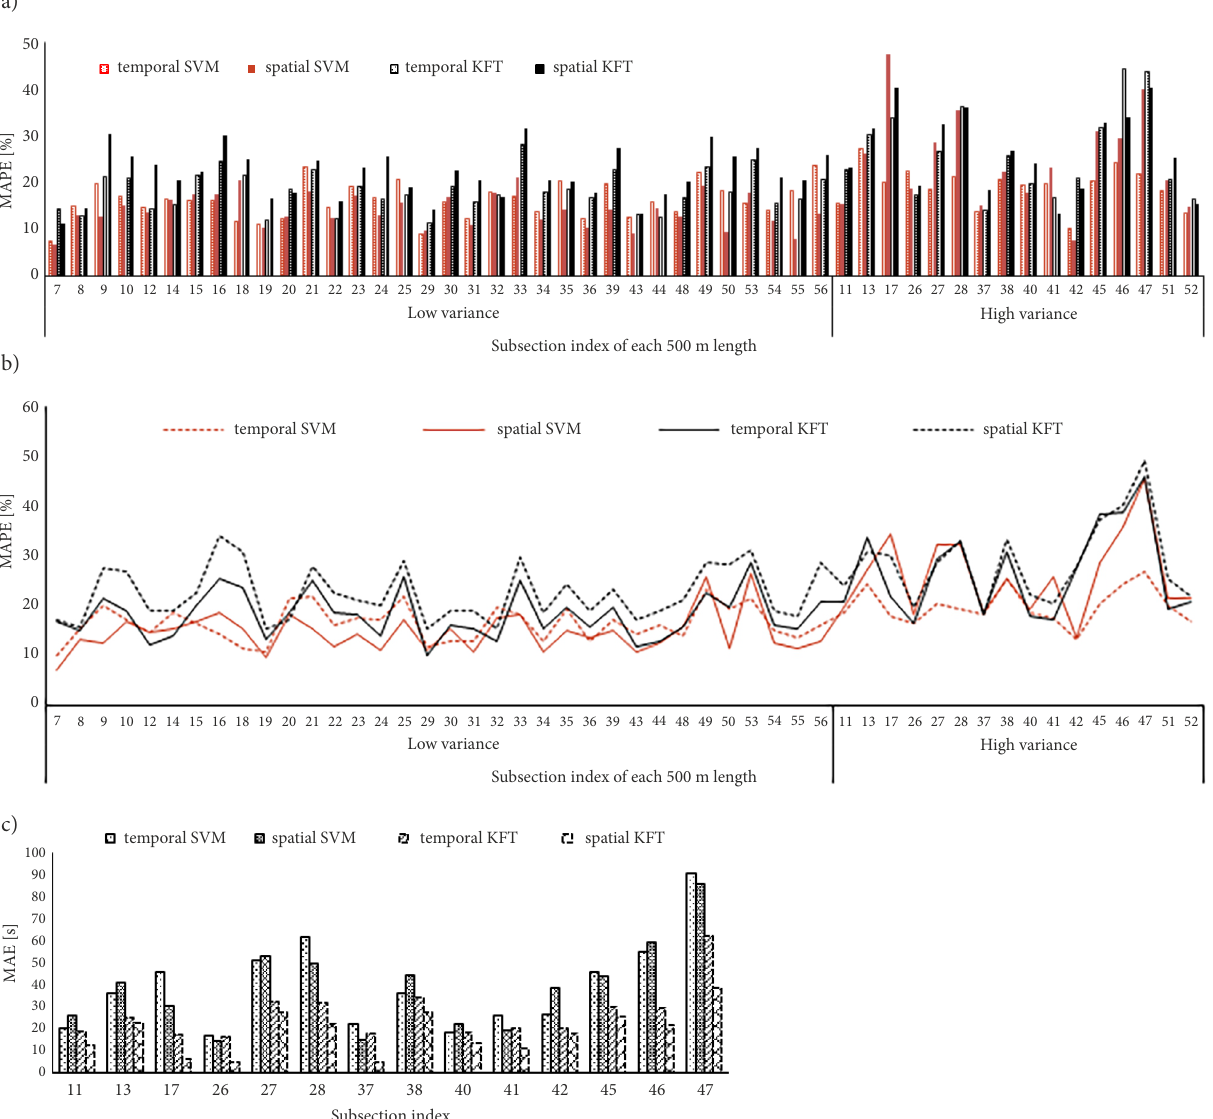
Figure 6. Performance comparison over subsections: a – for all methods in a sample day; b – for SVM methods; c – comparison of MAE for all prediction